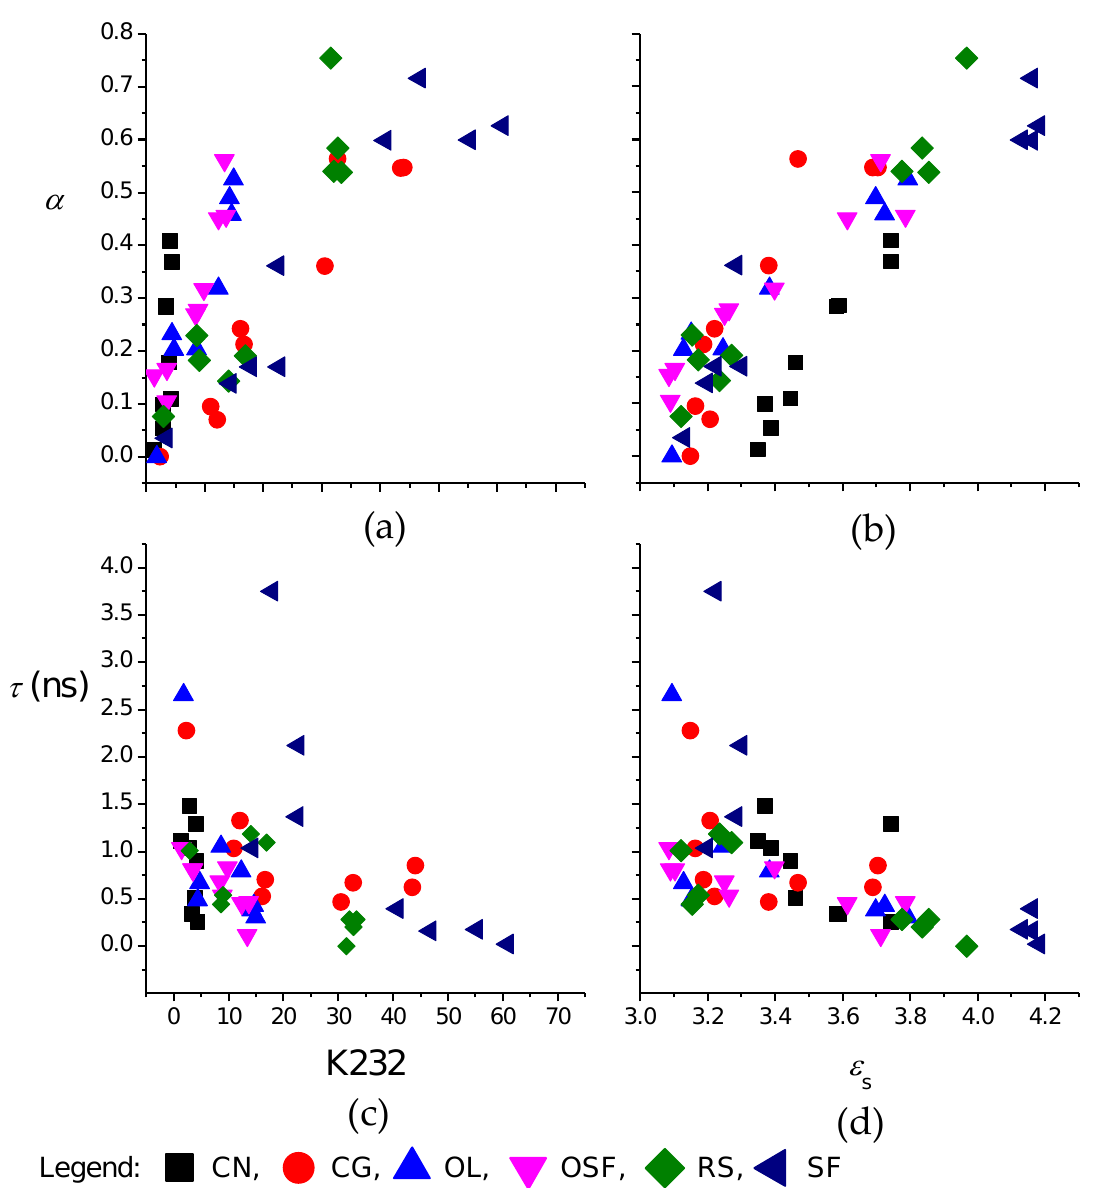
Figure 2. Dependence of the parameters from the Cole–Cole model, as exponent α ( a , b ) and mean relaxation time τ ( c , d ), on the sum of the specific absorption coefficients K232 + K268 ( a , c ) and the dielectric constant, ε s ( b , d ) for the edible oils thermally treated at 180 °C. CN, coconut oil; CG,